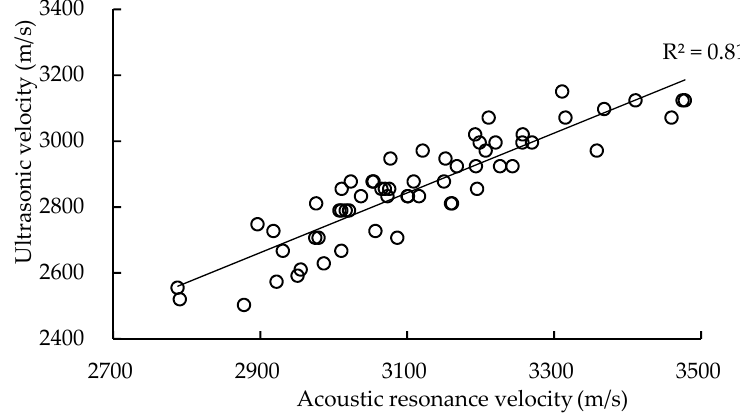
Figure 12. Relationship between ultrasonic velocity and acoustic resonance velocity.